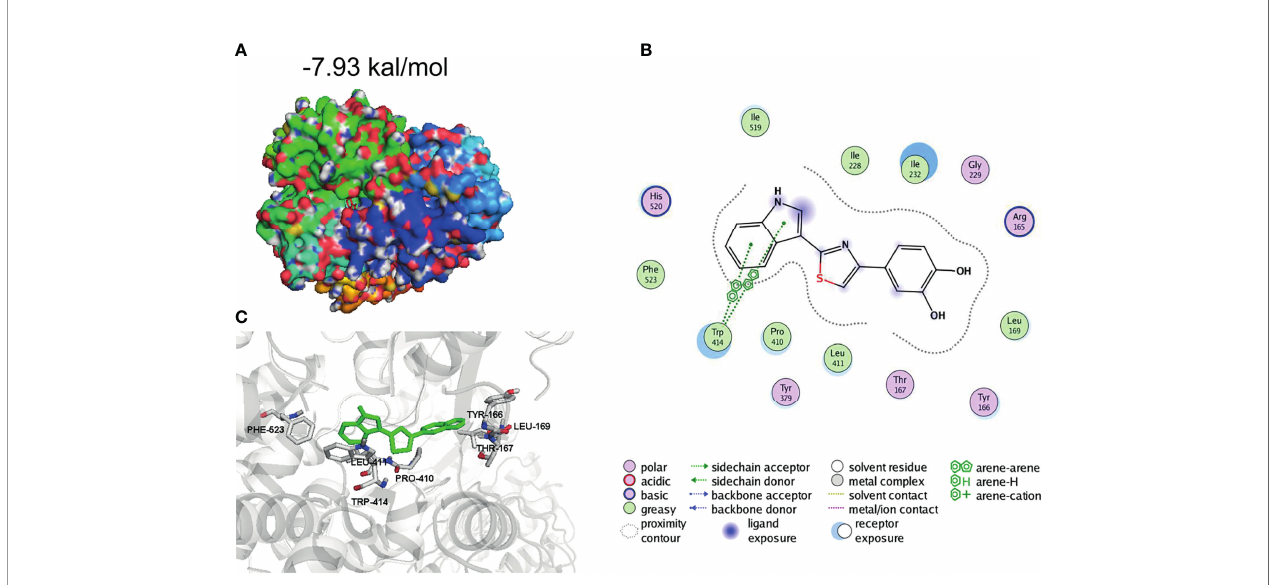
FIGURE 4 | 1,2-Diol was readily docked with NLRP3. (A, B) 3D binding mode diagrams between NLRP3 and the chemical 1,2-diol. The protein is shown in cartoon and colored in gray, key amino acid residues were shown as sticks. Docking score is − 7.93kcal/mol. (C) 2D mode diagrams the key amino residues in the ligand − protein